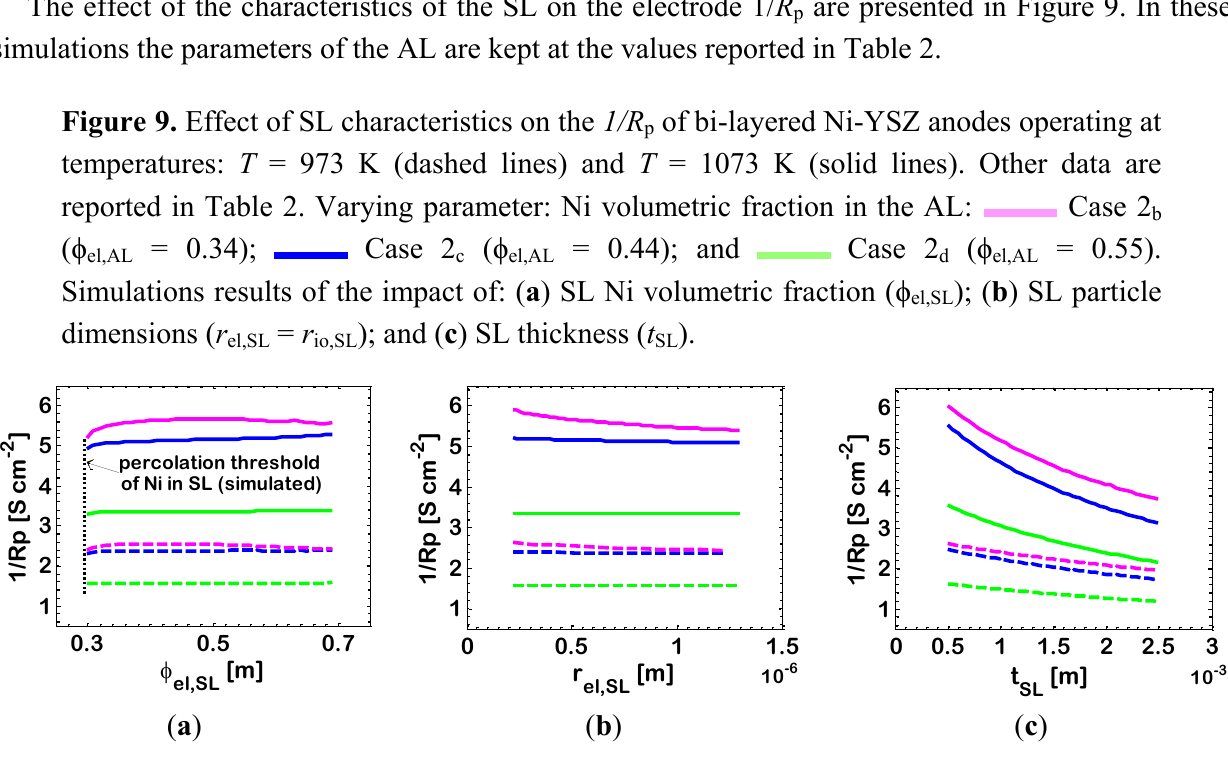
b (ϕ = 0.55). d el,AL ); ( b ) SL particle el,SL